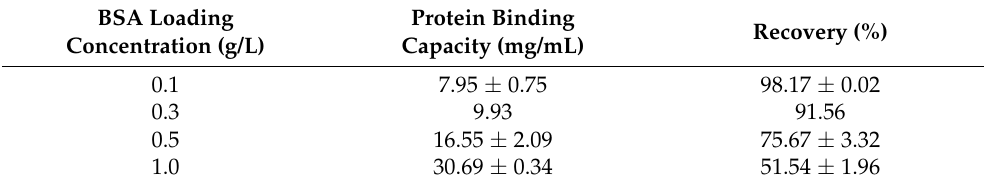
Table 3. The effect of protein feed concentration on DBC and product recovery for PVCL grafted with 80 mM initiator and 6 h